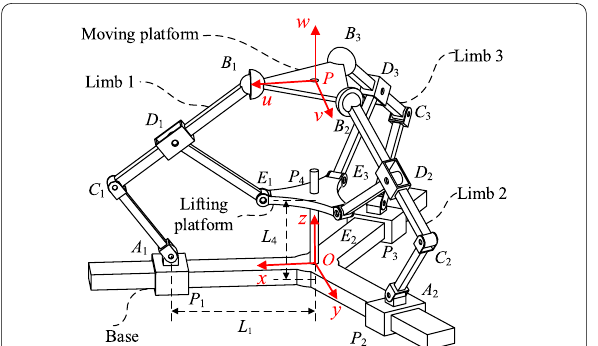
Figure 1 The model of 3-DOF PM-KR